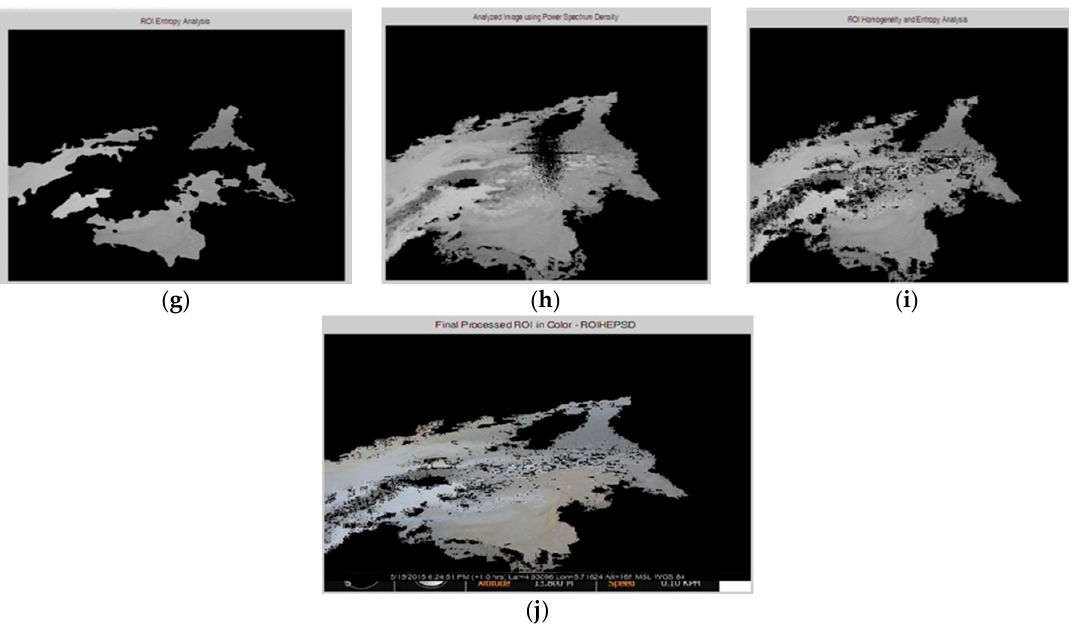
Figure 3. Oil Spill Detection Algorithm Implementation on Case Image OS69. ( a ) Case Image OS69; ( b ) Preprocessed image; ( c ) Color Segmentation Image; ( d ) Sky Segmentation Image; ( e ) Selected Primary ROI; ( f ) ROI homogeneity Image; ( g ) Entropy Image; ( h ) PSD image; ( i ) ROI homogeneity and entropy features; ( j ) Detected Crude Oil Spill from OS69.